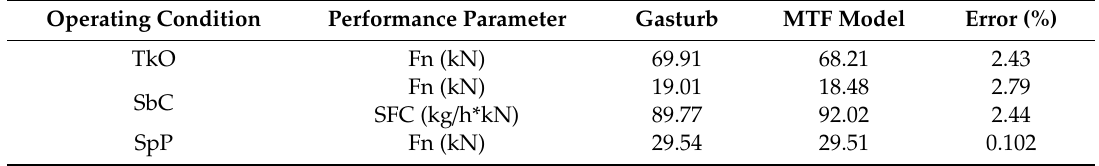
Table 5. Simulation comparison results of Gasturb ® and turbofan model. MTF = mixed flow turbofan